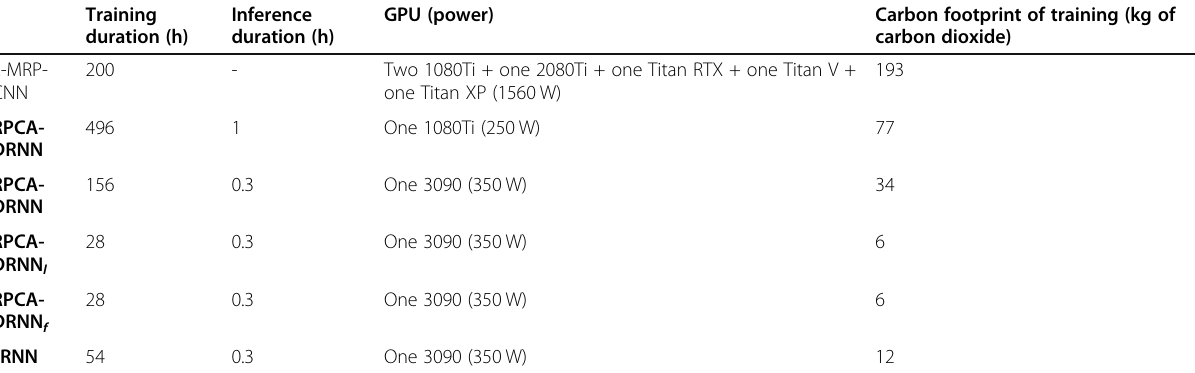
Table 10 The training duration, inference duration, GPU (power), and carbon footprint of training on MUSDB18 of RPCA-DRNN methods, sRNN and